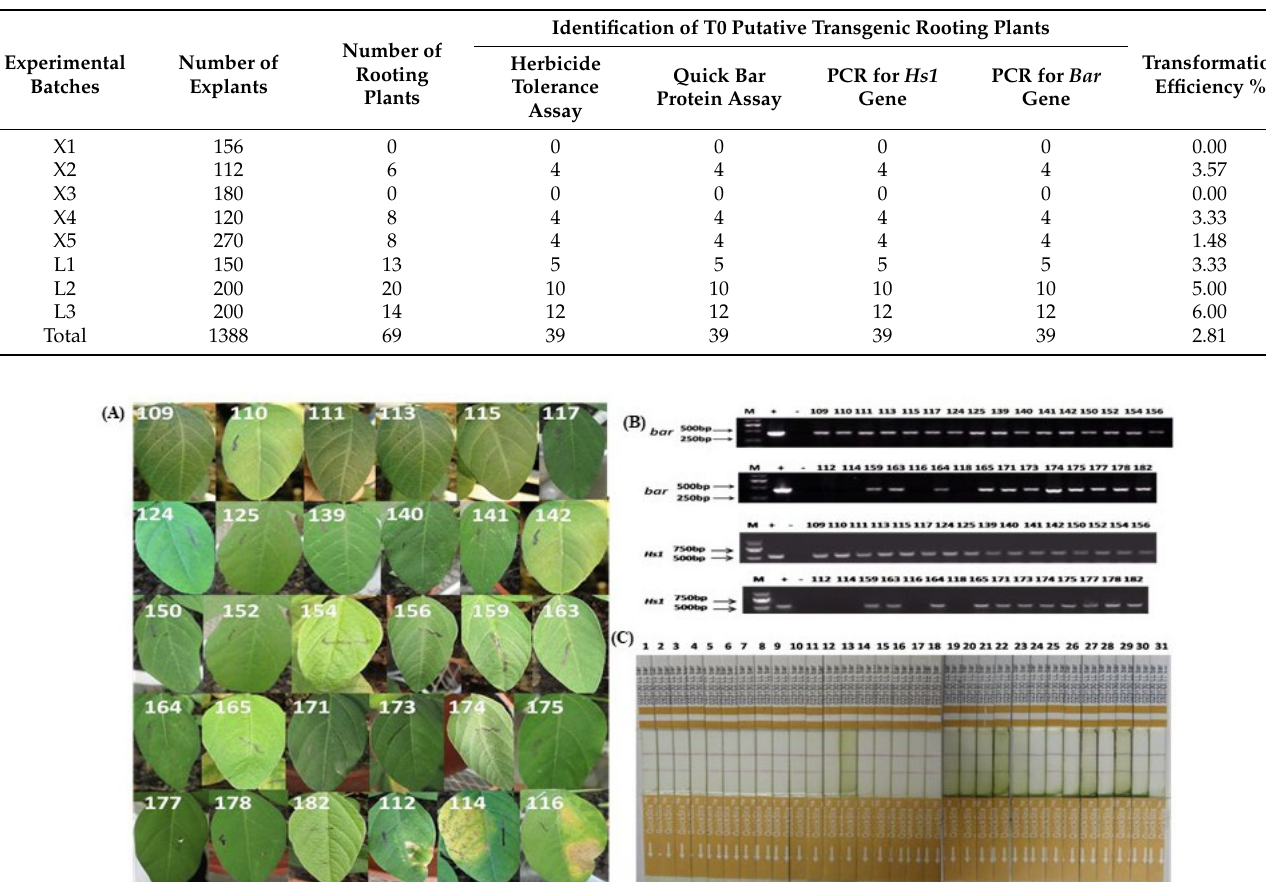
Table 1. T0 putative transgenic plant identification and transformation efficiency.